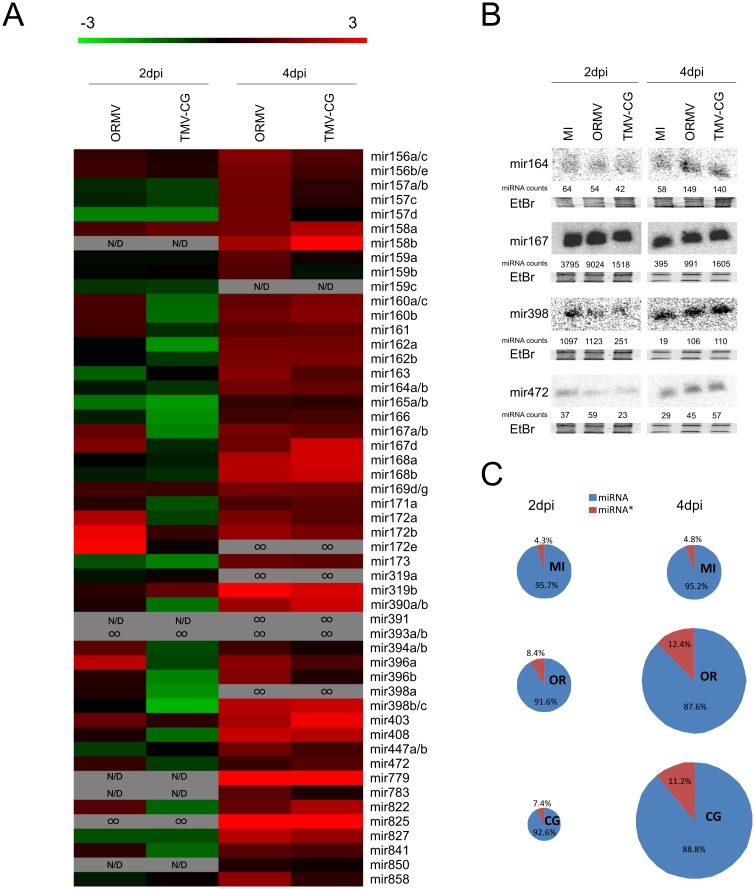
Micro RNA and miRNA* profile upon tobamovirus infection at 2 and 4dpi by high-throughput sequencing.(A) Heatmap showing log2-fold changes of average normalized miRNA reads in a double-color scale for distinct miRNAs families. Comparisons were made between mock-inoculated and TMV-Cg or ORMV-infected plants. N/D = Not detected. ∞ = Detected only in virus infected samples. For details see Supplementary S5 Table. (B) Northern blot validating the high-throughput sequencing experiments of miRNAs. Numbers are the average count reads of each miRNA family in the high-throughput sequencing experiments. (C) Effect of tobamovirus infection in the miRNA/miRNA* profile. TMV-Cg and ORMV infection produces significantly higher levels of miRNA* sequences both at 2dpi (when no virus is detected) and at 4dpi (when viral accumulation is detected). Circles size represents the miRNA amounts in each treatment.